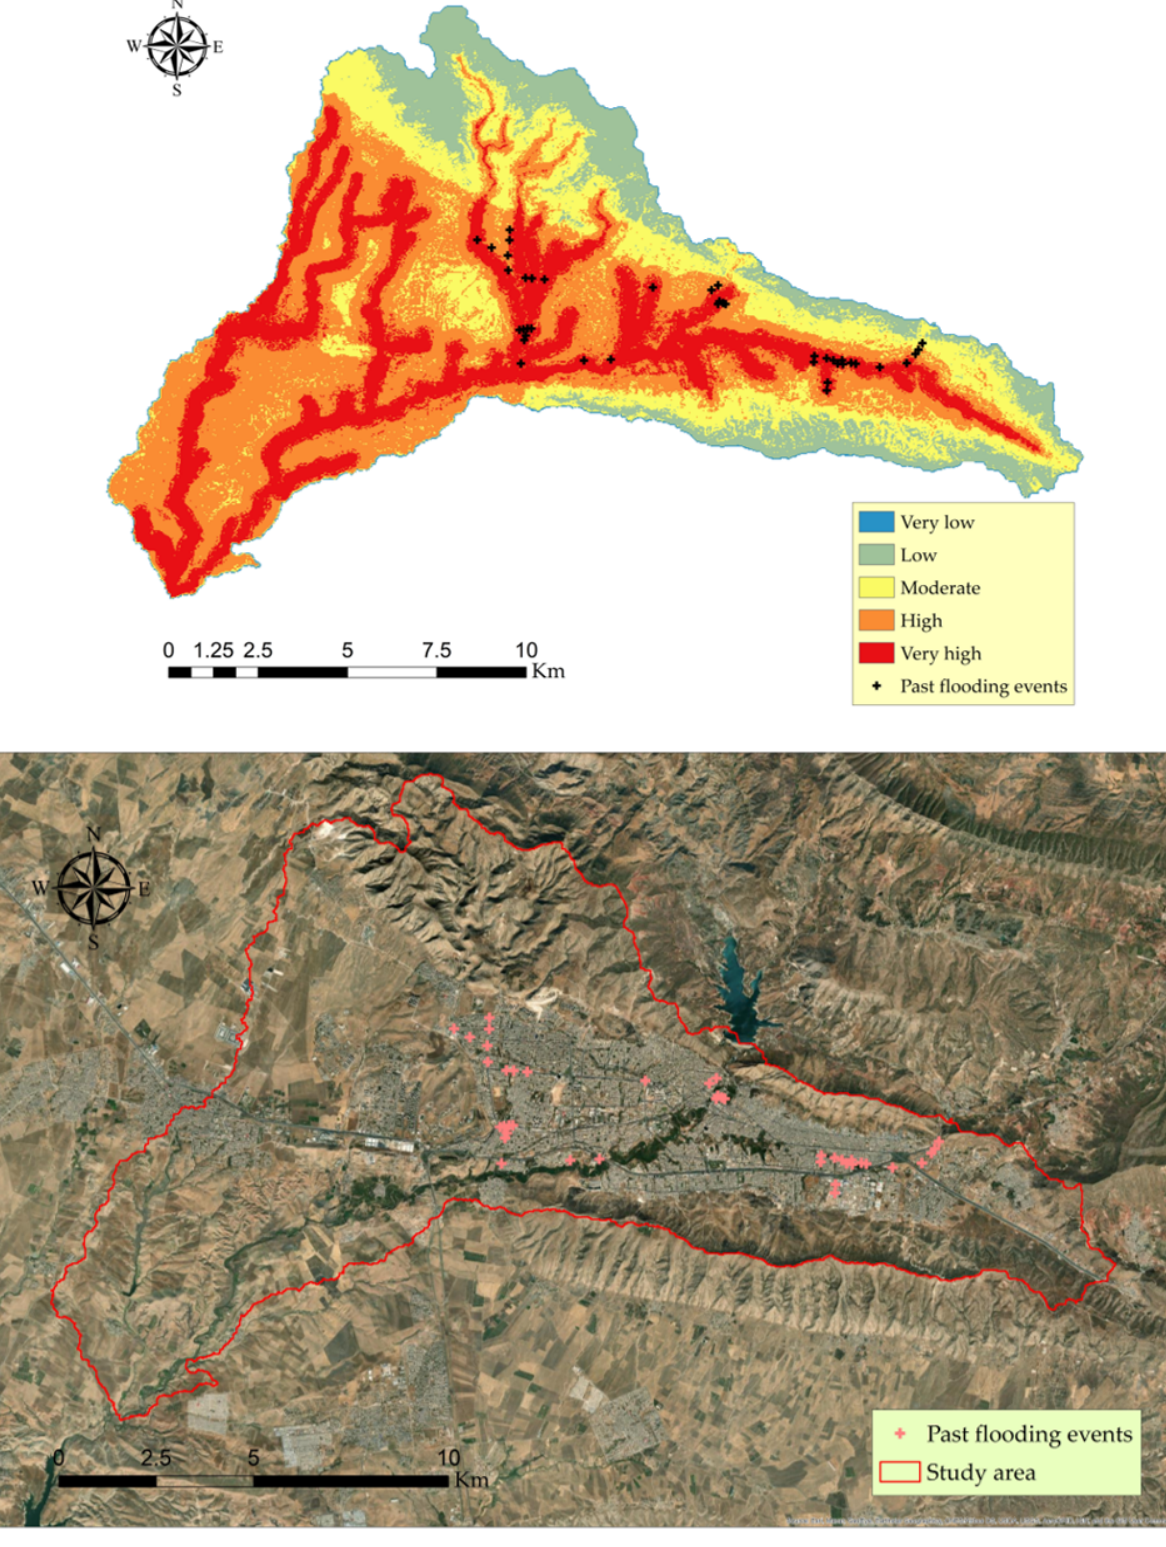
Figure 7. Flood Susceptibility Map with historic flood location. (Base imagery sources: Esri, Digital- Globe, GeoEye, i-cubed, USDA FSA, USGS, AEX, Getmapping, Aerogrid, IGN, IGP, swisstopo, and the GIS User